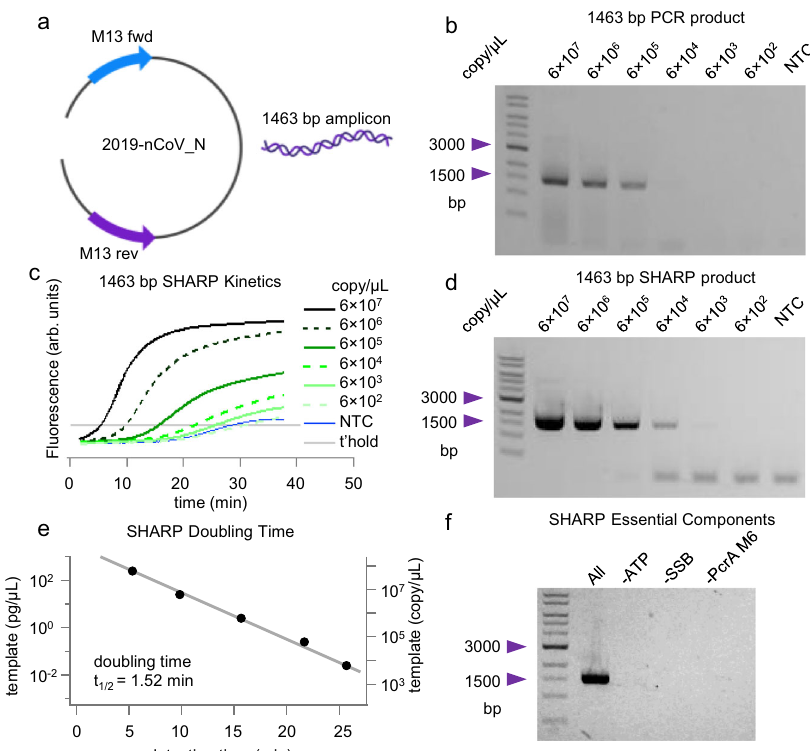
Fig. 2 | PCR and SHARP ampli fi cation product. a 2019 coronavirus nCoV-2 N protein sequencebetween M13primers. b PCR productand detection limitfor the template-primer set in a . c Kinetics of the SHARP reaction for the template primer set in a and different template concentrations. NTC is no template control and t ’ hold is the chosen detection threshold. d SHARP product and detection limit